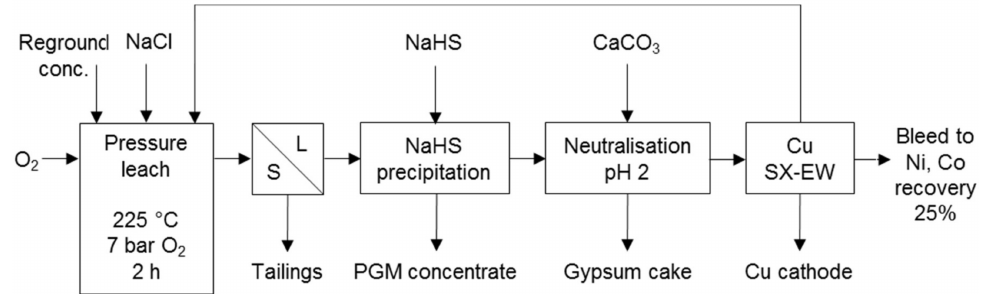
Figure 6. Flow sheet for the Platsol treatment of NorthMet concentrate. NaCl addition was 5–20 g/L. Adapted from Cole and Ferron [7].